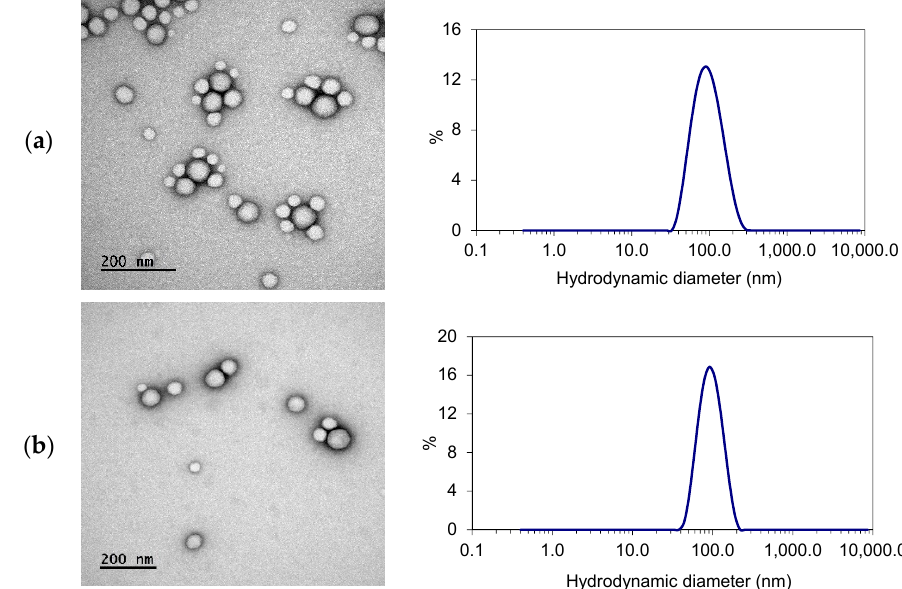
Figure 7. Typical TEM images and representative particle size distribution plots of ( a ) Nile red-labelled and ( b ) retinol-loaded (PEG– block –PLA)-blend-(PLA) nanocarriers. Table 1. Characteristics of nanocarriers (mean values ± SD, n = 3).